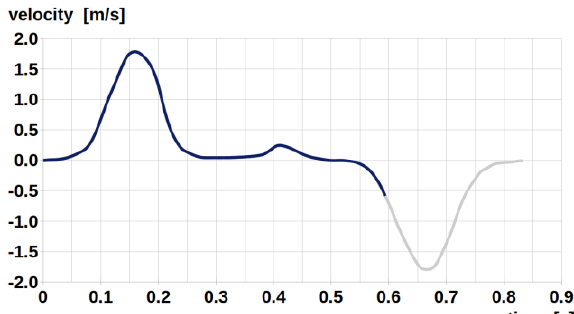
Fig. 2. Time-dependent velocity BC on inlet. The marked part was simulated (the interruption indicates the valve closure).